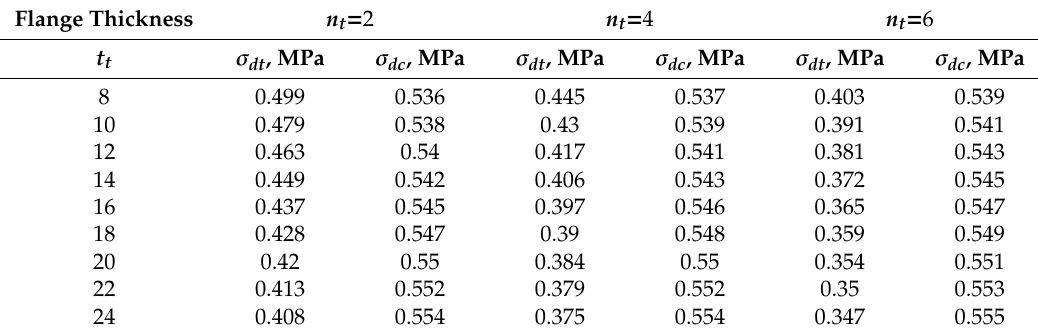
Figure 10. Dependence of the dynamic normal stresses on the thickness of the flange t t of the I-beam and the number of reinforcement bars in the tension zone of the fiber-reinforced concrete beam, taking into account the mass of the beam and without the bimodularity at n c = 2, E c = 5000 MPa, E t = 5000 MPa: ( 1 ) dynamic tensile stresses at n t = 2; ( 2 ) dynamic compressive stress at n t = 2; ( 3 ) dynamic tensile stresses at n t = 4; ( 4 ) dynamic compressive stress at n t = 4; ( 5 ) dynamic tensile stresses at n t = 6; ( 6 ) dynamic compressive stresses at n t = 6. Table 9. Dependences of dynamic normal stresses on the thickness of the flange t t of the I-beam and the number of reinforcement bars in the tension zone of the fiber-reinforced concrete beam, taking into account the mass of the beam and without the bimodularity at n c =